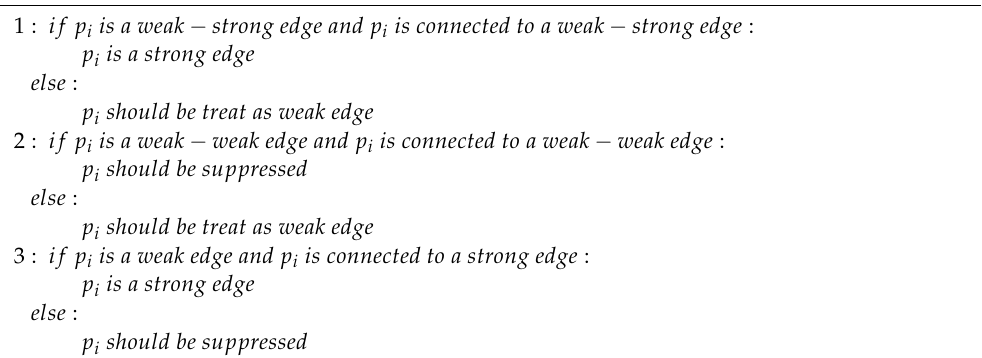
Algorithm 3 Suppressing isolated edge